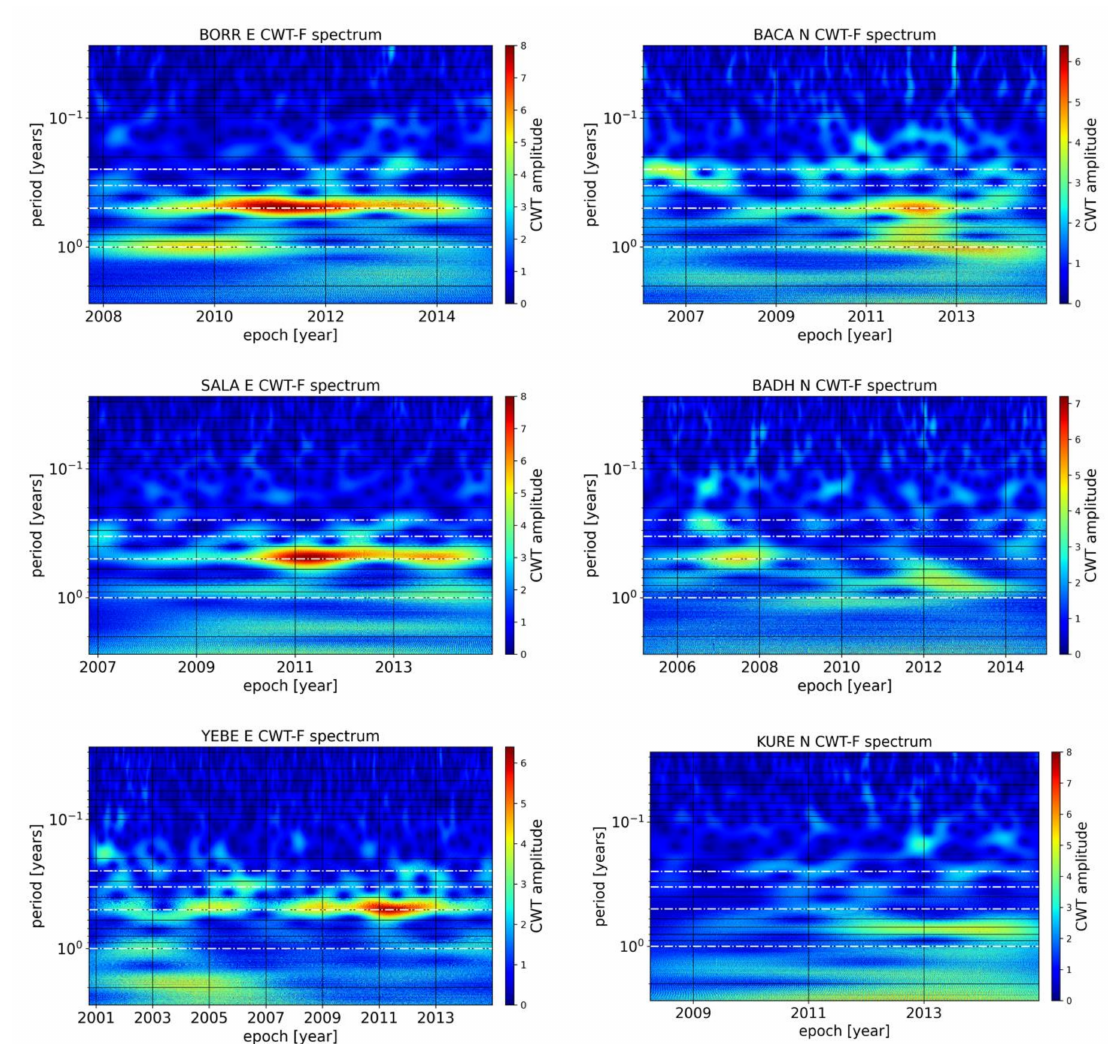
Figure 13. Examples of time-frequency spectra for stations with dominating semi-annual period ( left column ) and other periods ( right column ) visible in coordinate time